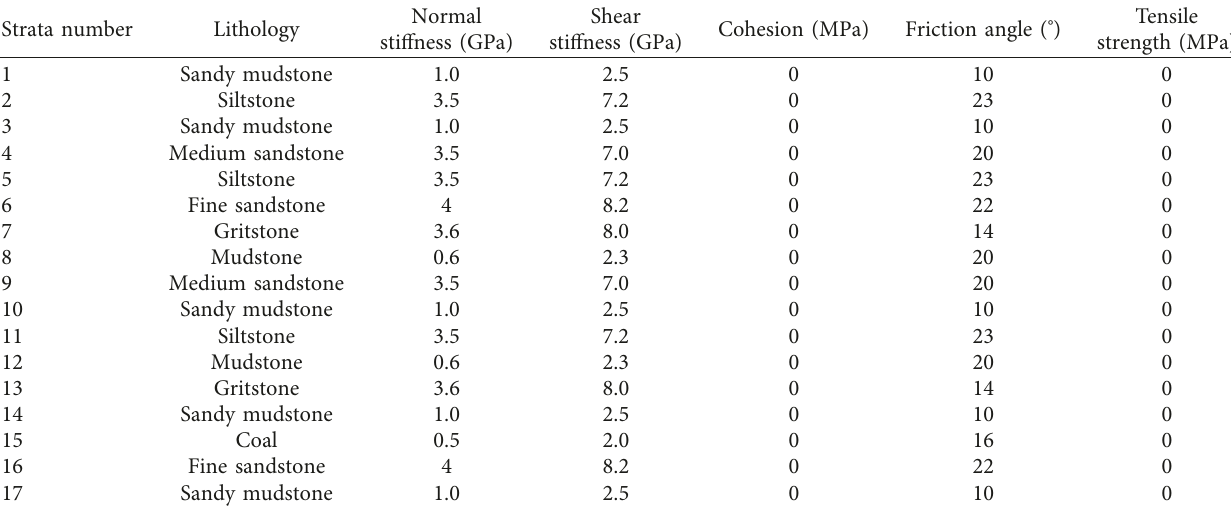
Figure 3: Schematic diagram of the numerical model and boundary conditions. Table 1: Coal and rock interface mechanical parameters used in the